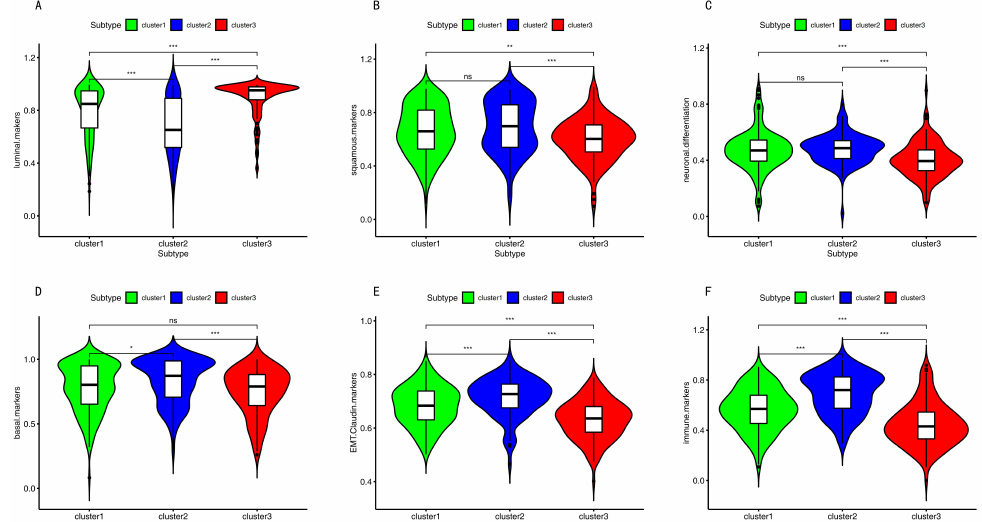
Figure 6. The bio markers of other subtypes among three subgroups. ( A – F ) The biomarkers of other subtypes among three subgroups. Three asterisks indicate a p -value less than 0.001. Two asterisks indicate a p -value less than 0.01. One asterisk indicates a p -value less than 0.05. Ns indicates no